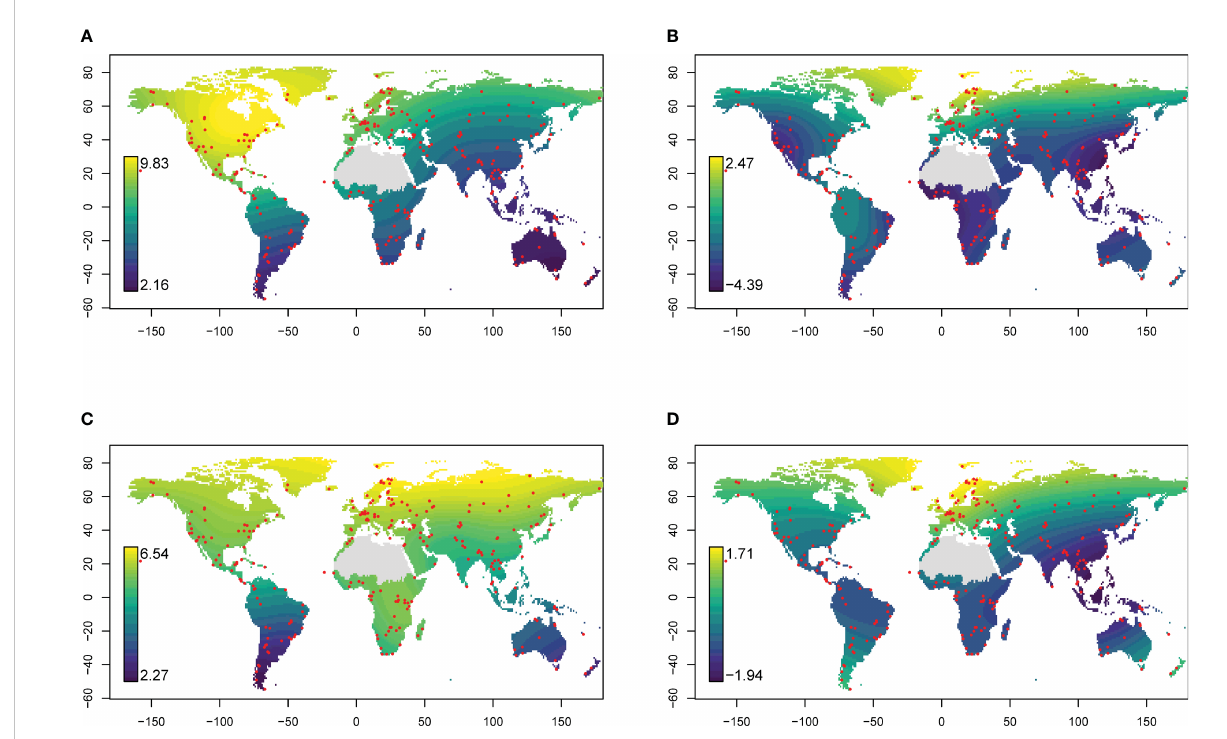
FIGURE 4 Relative success of taxonomic assignment of eDNA reads (trnL P6 loop). Values are the logarithm of the ratio between the number of reads (A, B) or OTUs (C, D) getting a match against trnL intron sequence data in INSDC at family (A, C) or species (B, D) level and the number not getting a match. Higher values indicate greater proportions of reads or OTUs getting a match. Red points indicate sampling locations. Global predictions are the result of a generalised additive model. The Sahara region was excluded from interpolations because of insuf fi cient